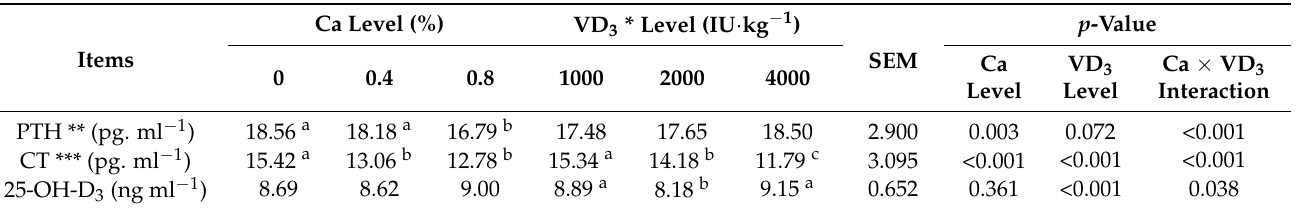
Table 7. The outcome of Ca and VD 3 diet supplementation on serum hormone concentration in maturing and furring blue